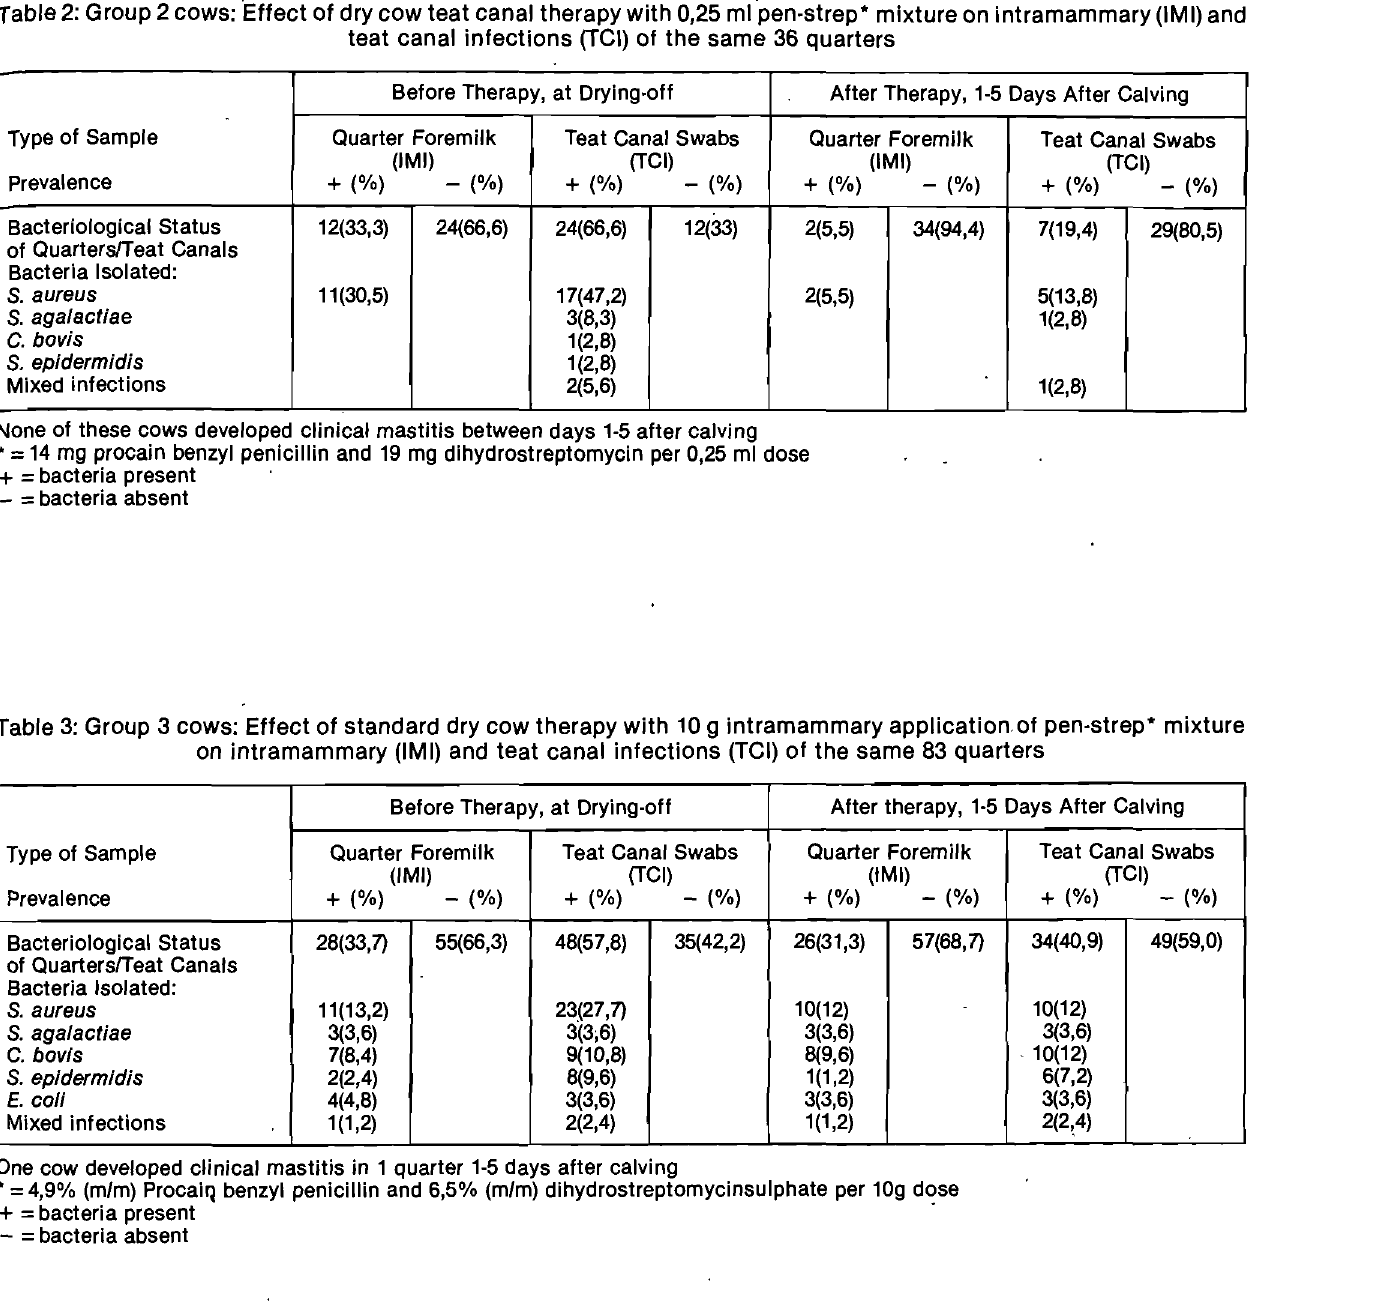
Table 2: Group 2 cows: 'Effect of dry cow teat canal therapy with 0,25 ml 'pen-strep· mixture on intramammary (IMI) and teat canal infections (TCI) of the same 36 quarters